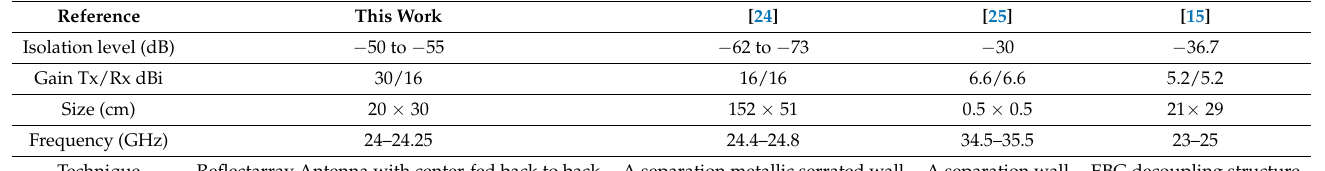
Table 1. Comparisons of antennas back-to-back method with other